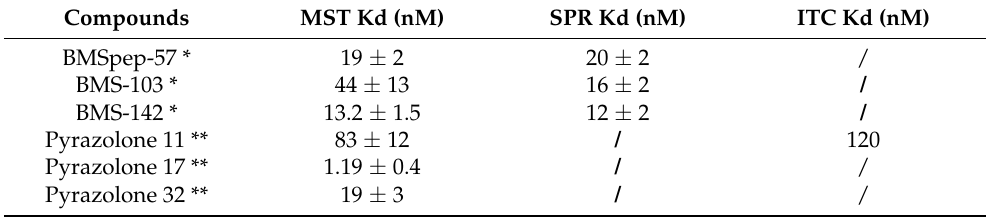
Table 2. PD-L1 binding of selected small molecules evaluated by MST compared to SPR and ITC. Compounds